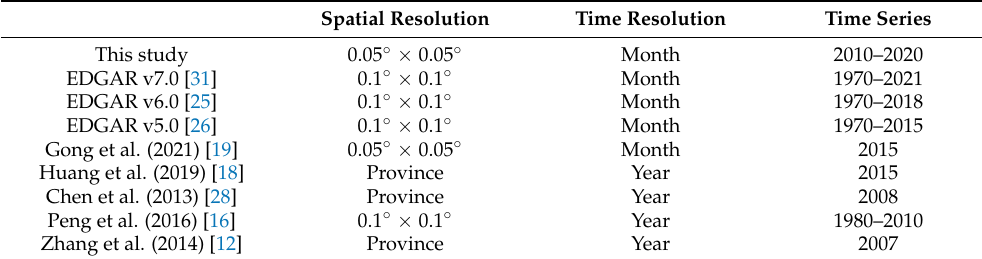
Table 6. Comparison with other research results in spatiotemporal resolution and time series.